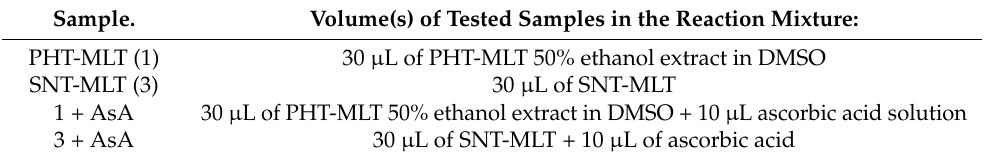
Table 3. The experimental design and volumes of the tested samples, with and without the addition of vitamin C (AsA) applied in the study on COX-2 inhibitory